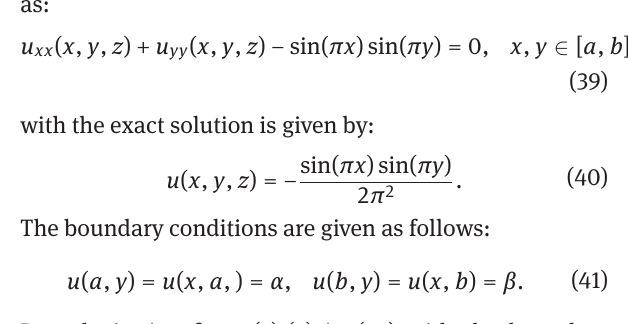
mann numbers 0 (top curve), to 8 (bottom curve) at [−0.5, 0.5] using a mesh of 50 × 50 .